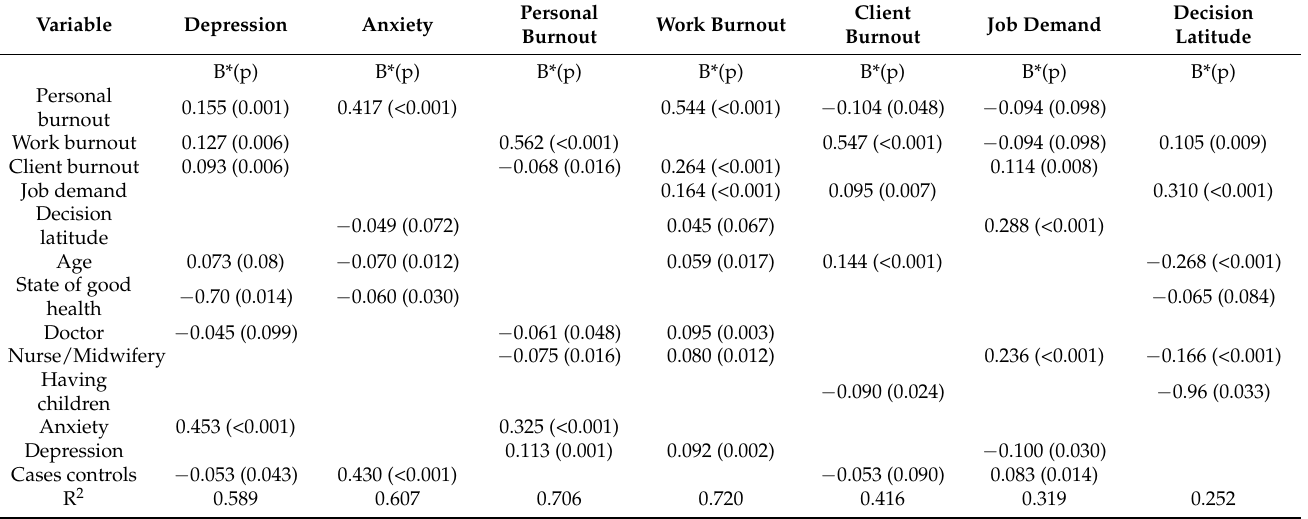
Table 4. Multivariate